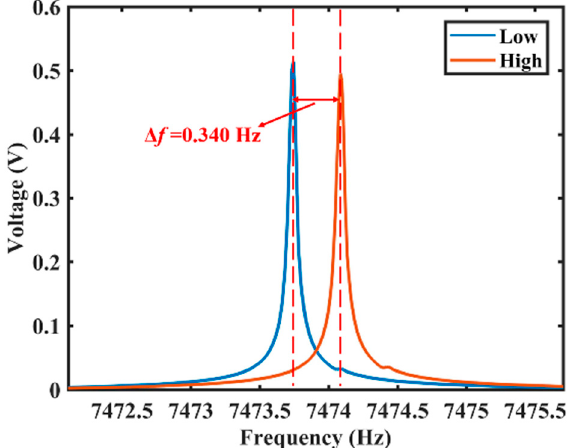
Figure 10. The FFT results of the output voltage signal of two vibrating modes with di ff erent frequencies. The blue line represents exciting in the direction of the low-frequency principal axis, and the red line represents exciting in the direction of the high-frequency principal axis.